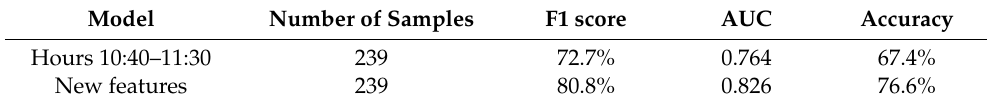
Table 13. Results of a dataset from 10:40 a.m. to 11:30 a.m. and after a new feature selection.